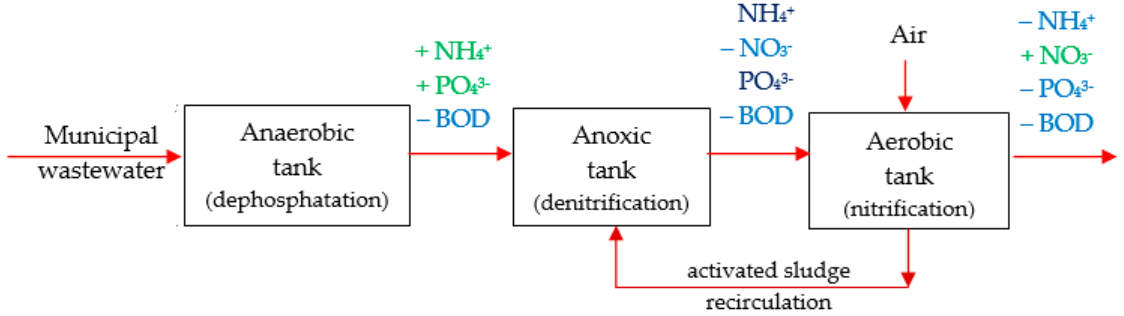
Figure 2. A process flowchart for a suspended-activated-sludge WWTP (inspired by [7–10]). It should be noted that the activated-sludge method is not ineffective as such.